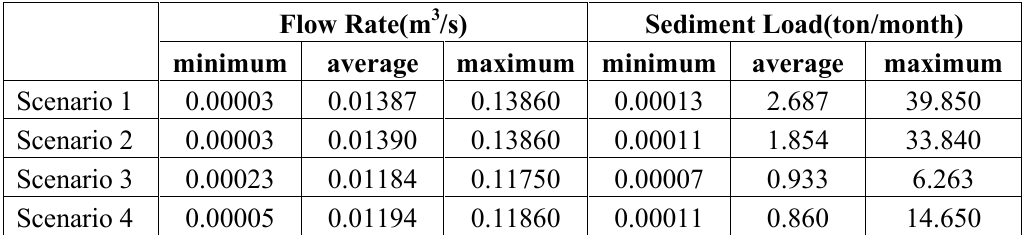
Table 2. Flow Rate and Sediment